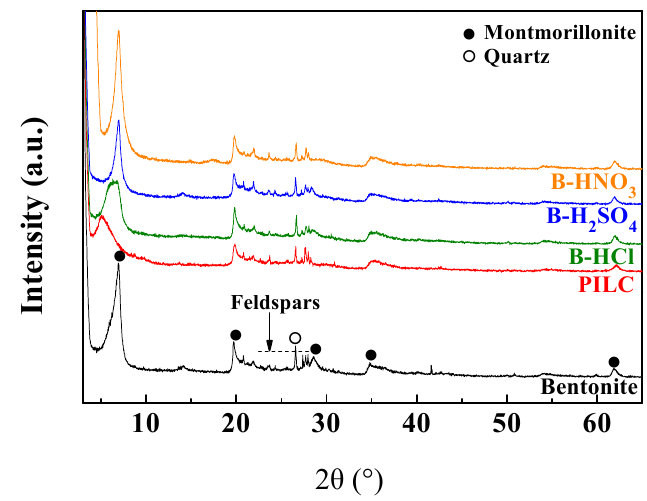
Figure 1. XRD diffractograms of raw bentonite, pillared interlayered clay (PILC), bentonite B-H 2 SO 4 , B-HNO 3 and B-HCl.